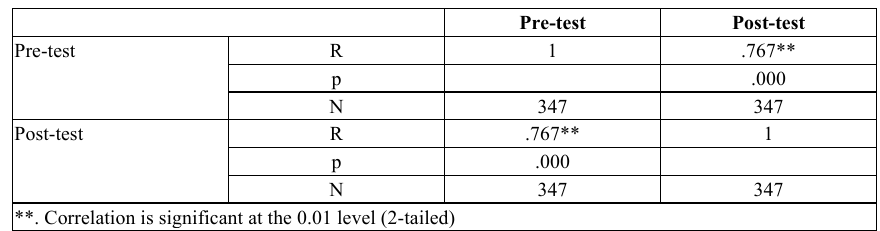
Table 3. Correlations between the pre- and post-test scores